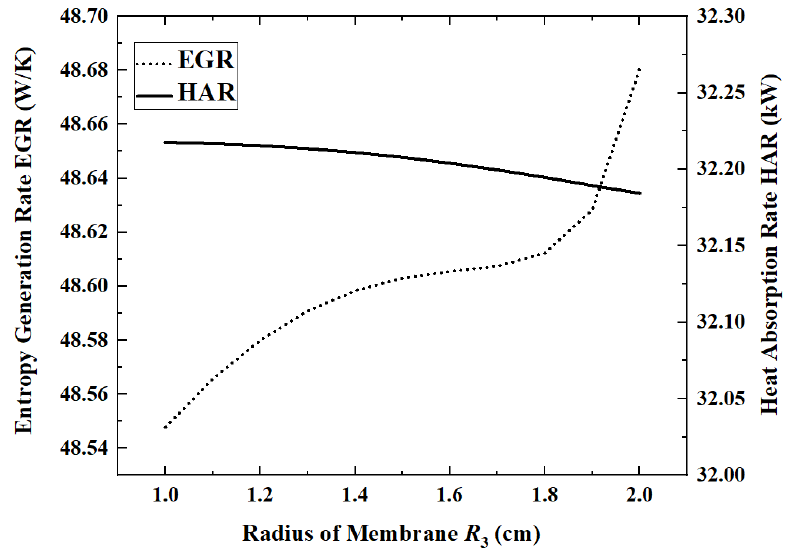
Figure 11. Effect of membrane radius on EGR and HAR.